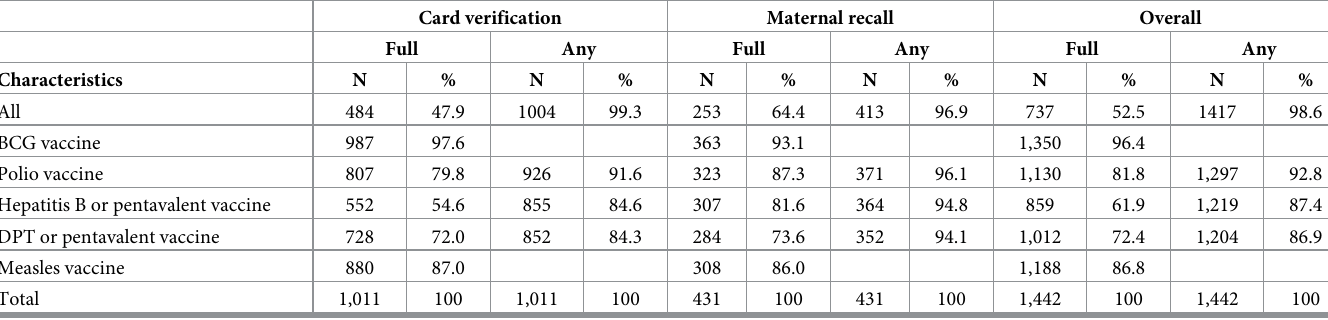
Table 3. Vaccination status according to data availability by vaccination